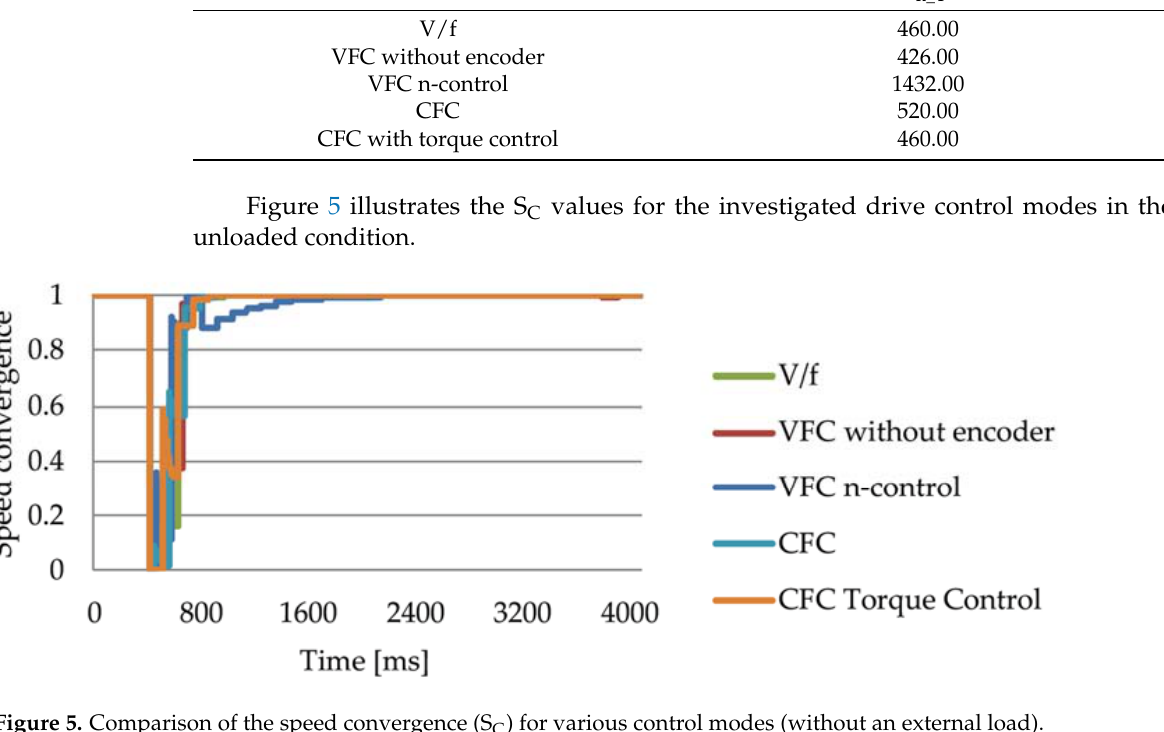
Table 9. Duration of the transient state (t n_T ) for the rotational speed n A (without an external load). Control Mode